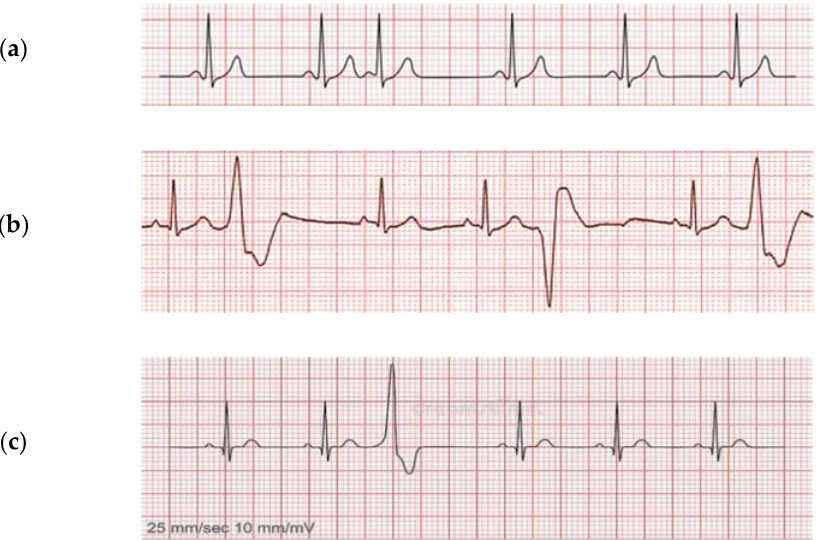
Figure 1. Premature Contraction examples: ( a ) Premature Atrial Contractions (PAC) in the third heartbeat; ( b ) periodical Premature Ventricular Contractions (PVC) of two different shapes in the second, fifth, and the seventh heartbeats; ( c ) single PVC with the first shape in the third heartbeat. PVC [2] is described as a very early heartbeat in the ventricles that follows a normal beat, and it causes a small pause in the heart and then a strong heartbeat due to the amount of blood that was collected in the heart during the pause. A PVC can show two different ECG curves depending on the amount of blood collected in the heart and the timing of